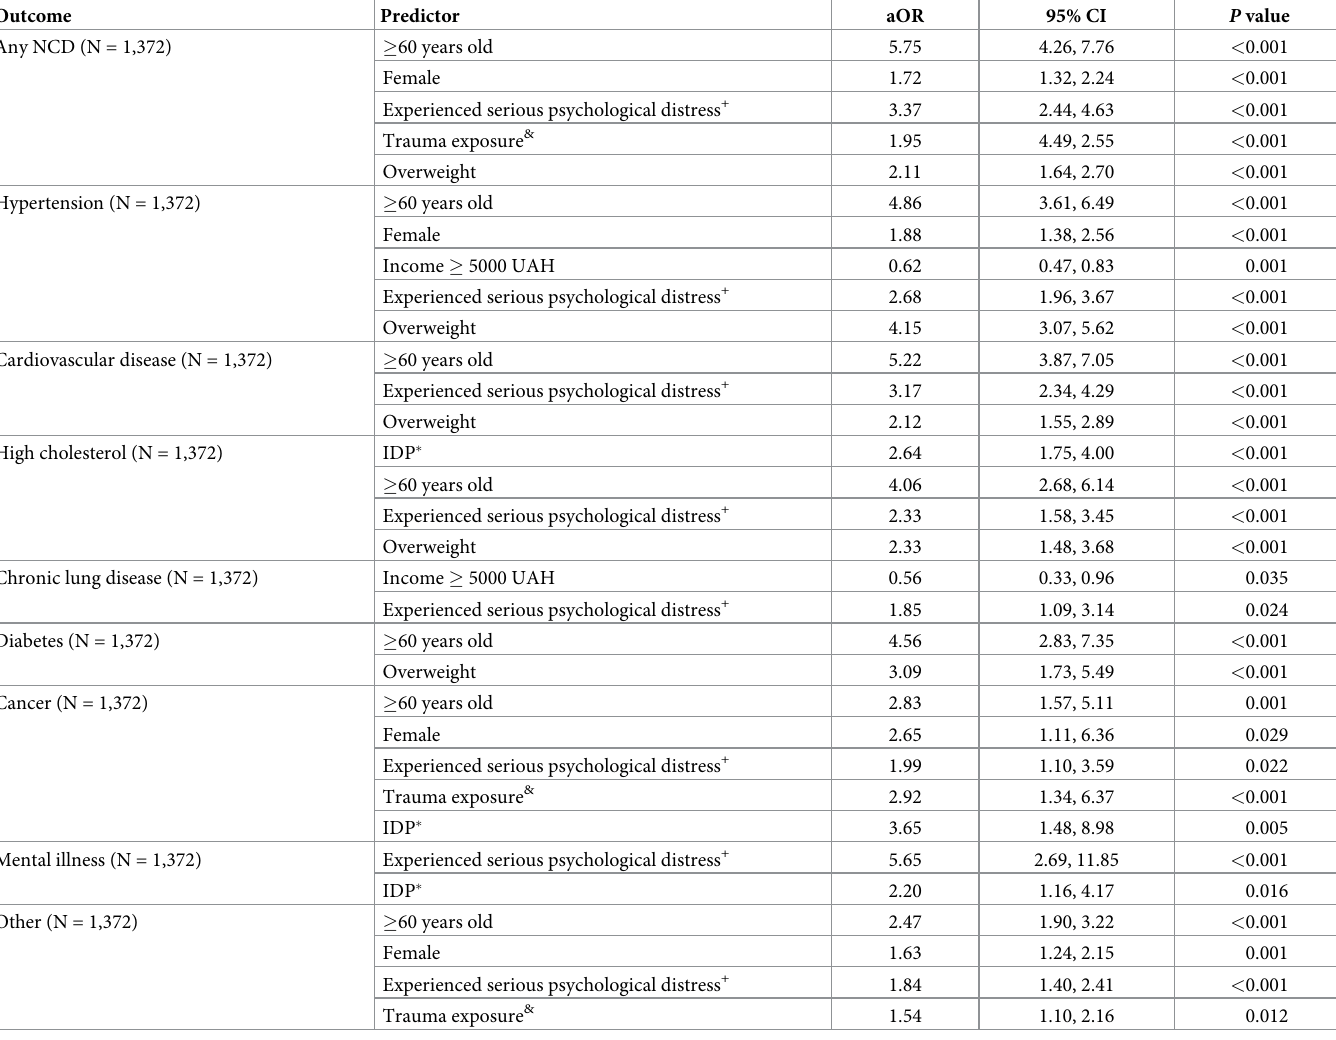
Table 3. Risk factors associated in multivariate logistic regression with NCD diagnoses among conflict-affected adults in Ukraine, 2018.